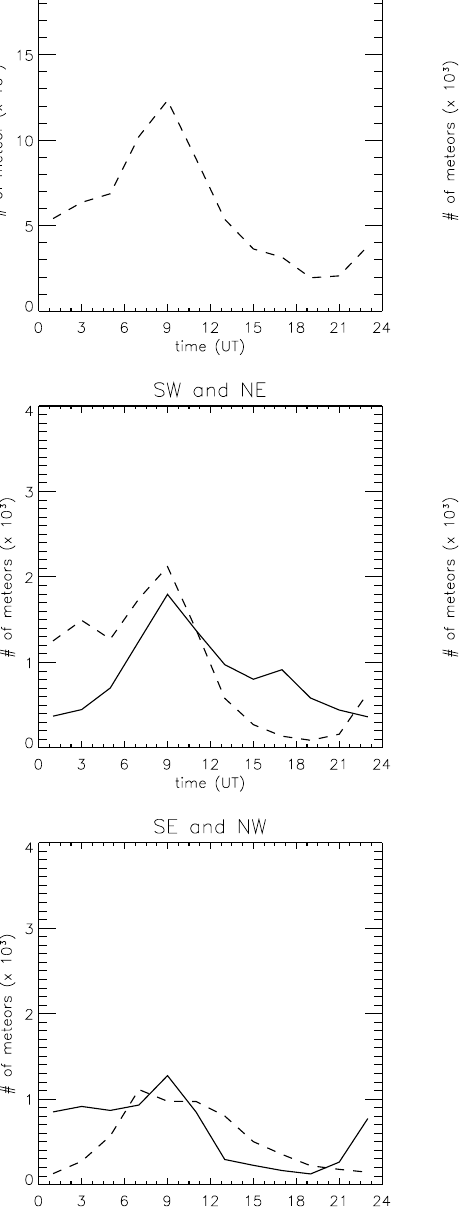
winds and tides. Figure 7 shows time-height contour plots of the variance components (left side) and the vertical flux of horizontal momentum (right side) for this meteor distribution using the modified composite day